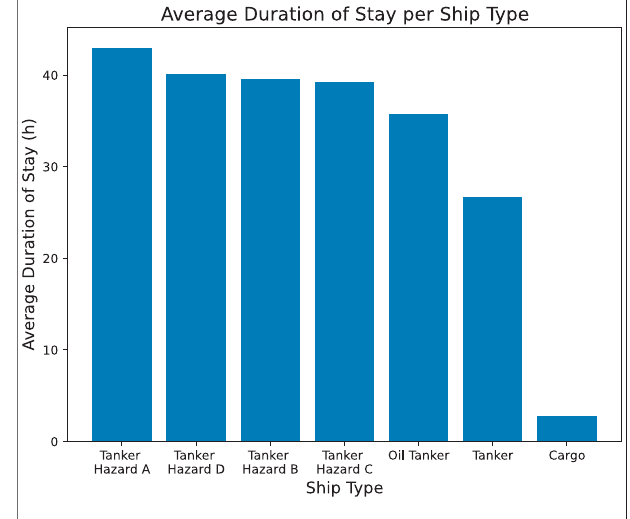
FIGURE 1 | Berth layout of the EVOS Terminal.